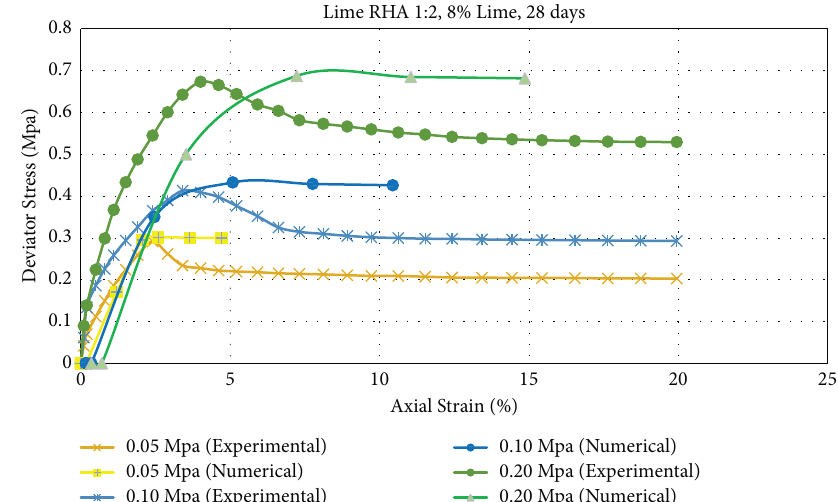
Figure 17: Correlation/validation of treated soil behaviour under triaxial compression. Stress deviation vs. axial strain (numerical and experimental)-LRHA treated